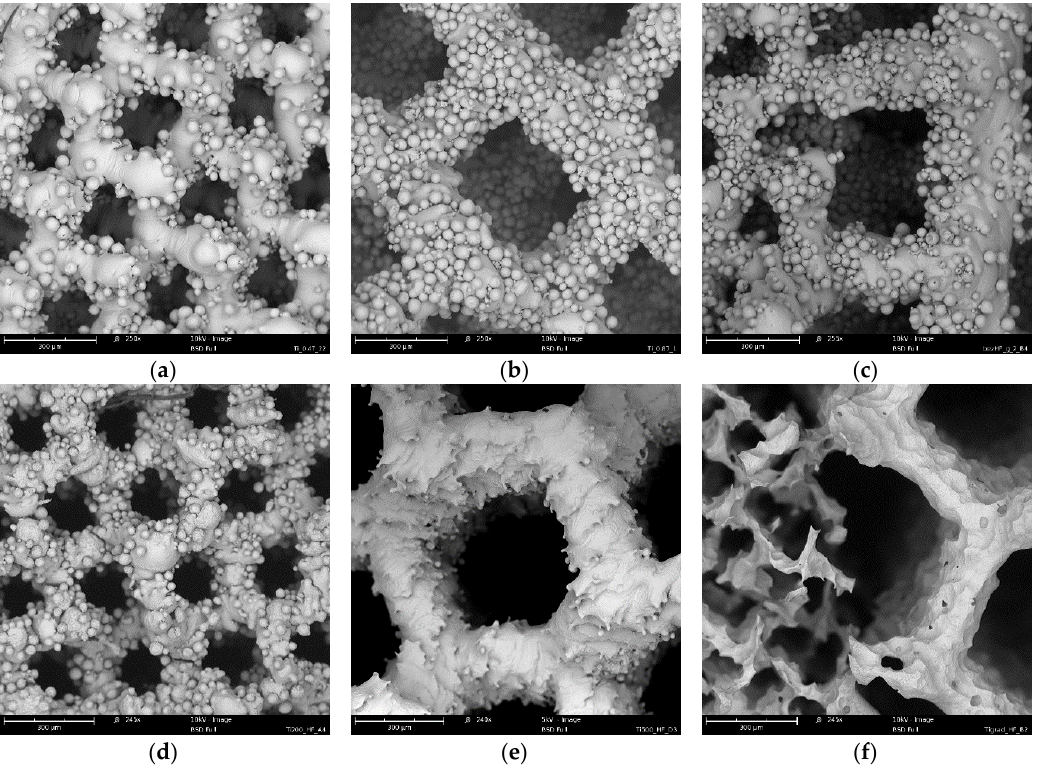
Figure 5. As made scaffolds with designed pores size equal: 200 µm ( a ); 500 µm ( b ); 200+500 µm ( c ) and exemplary images of scaffolds polished in HF baths: 200 µm—3%/1 min ( d ); 500 µm—1%/3 min ( e ); 200 + 500 µm—3%/6 min ( f ).